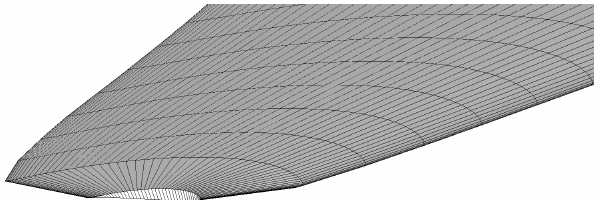
Figure 3. Surface mesh used for the UNAFLOW blade, showing tip